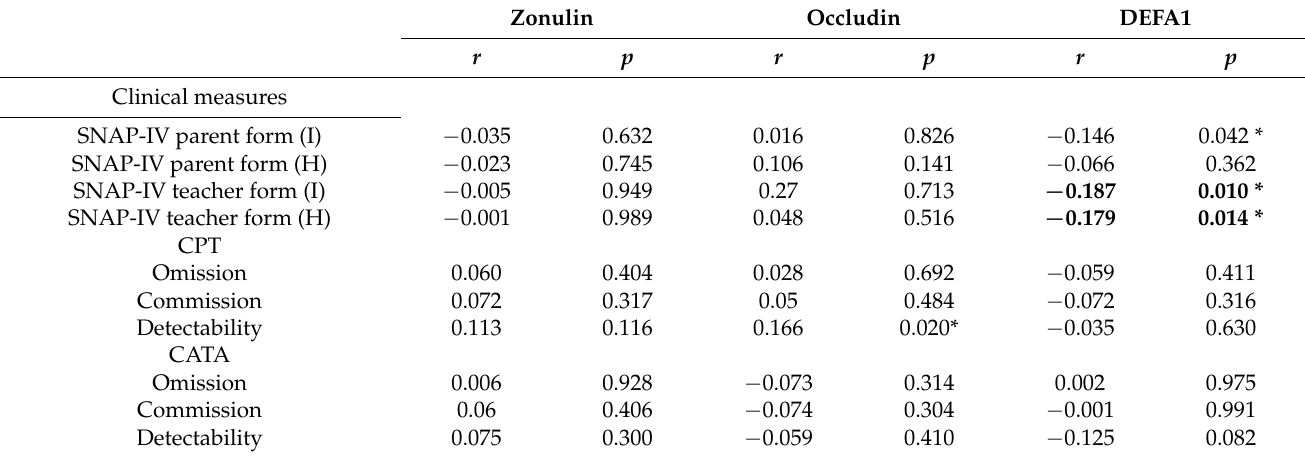
Table 3. The effect of ADHD status on DEFA1 levels examined using linear regression model, con- trolling for the potential confounding effects of sex and BMI.